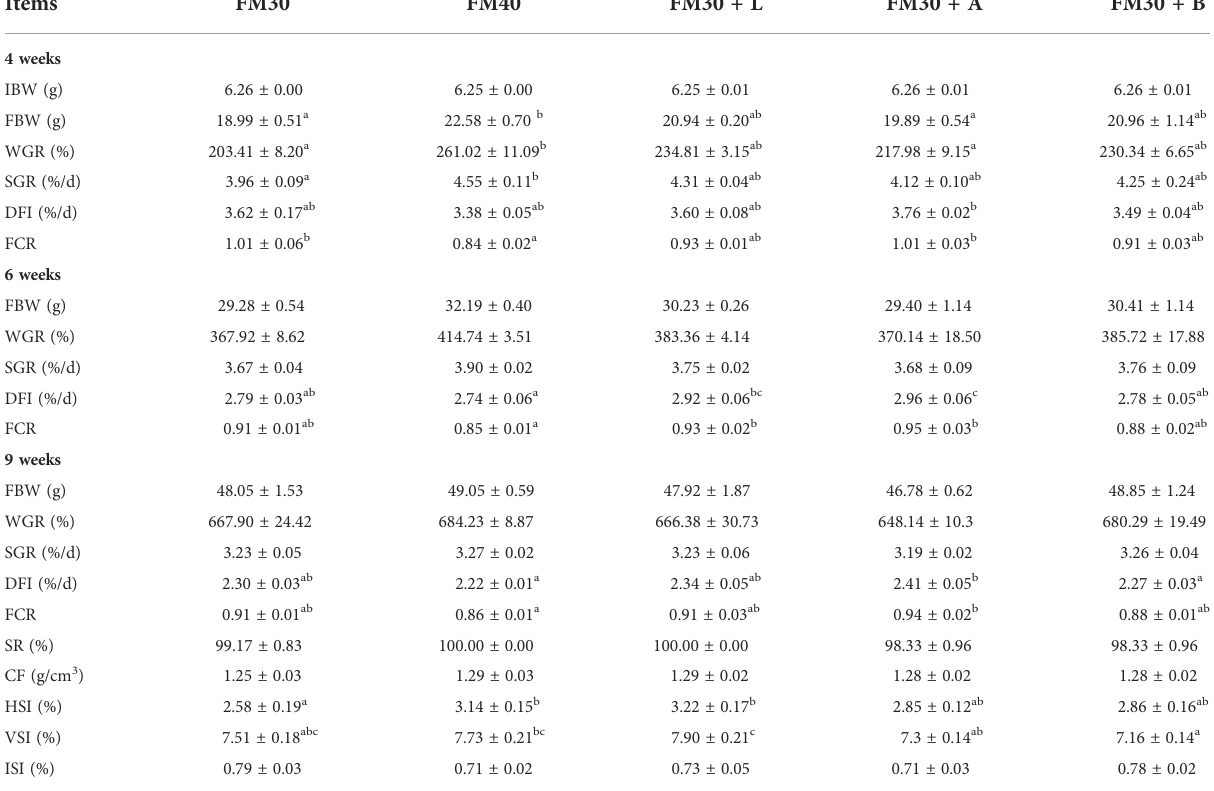
TABLE 3 Effects of limonene, allicin and betaine on growth performance of M. salmoides for 4, 6 and 9 weeks. Items